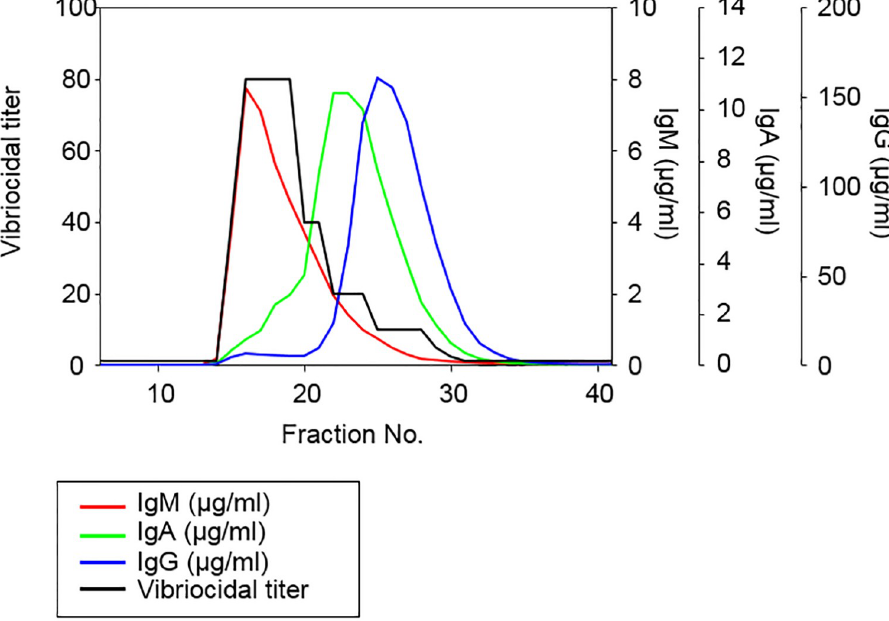
Fig 1. High vibriocidal activities were detected in the IgM fraction of the convalescent sera. Pooled convalescent sera were fractionated by size exclusion chromatography using Superdex 200 10/300GL. Vibriocidal titers and levels of total IgG, IgA, and IgM were determined in 40 fractionated serum